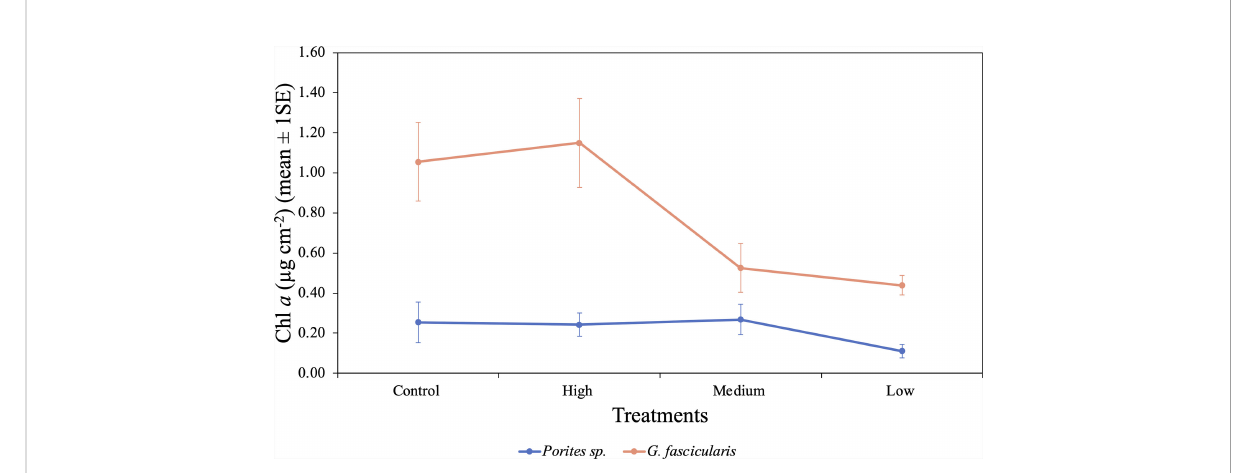
FIGURE 7 Mean (± 1SE) Chl a (µg cm − 2 ) rates for Porites sp. and G. fascicularis under four O 2 treatments. High and low O 2 treatments had greater Chl a content for G. fascicularis , while control and medium O 2 treatments presented a minor density. Porites sp. presented similar protein content between all four treatments.